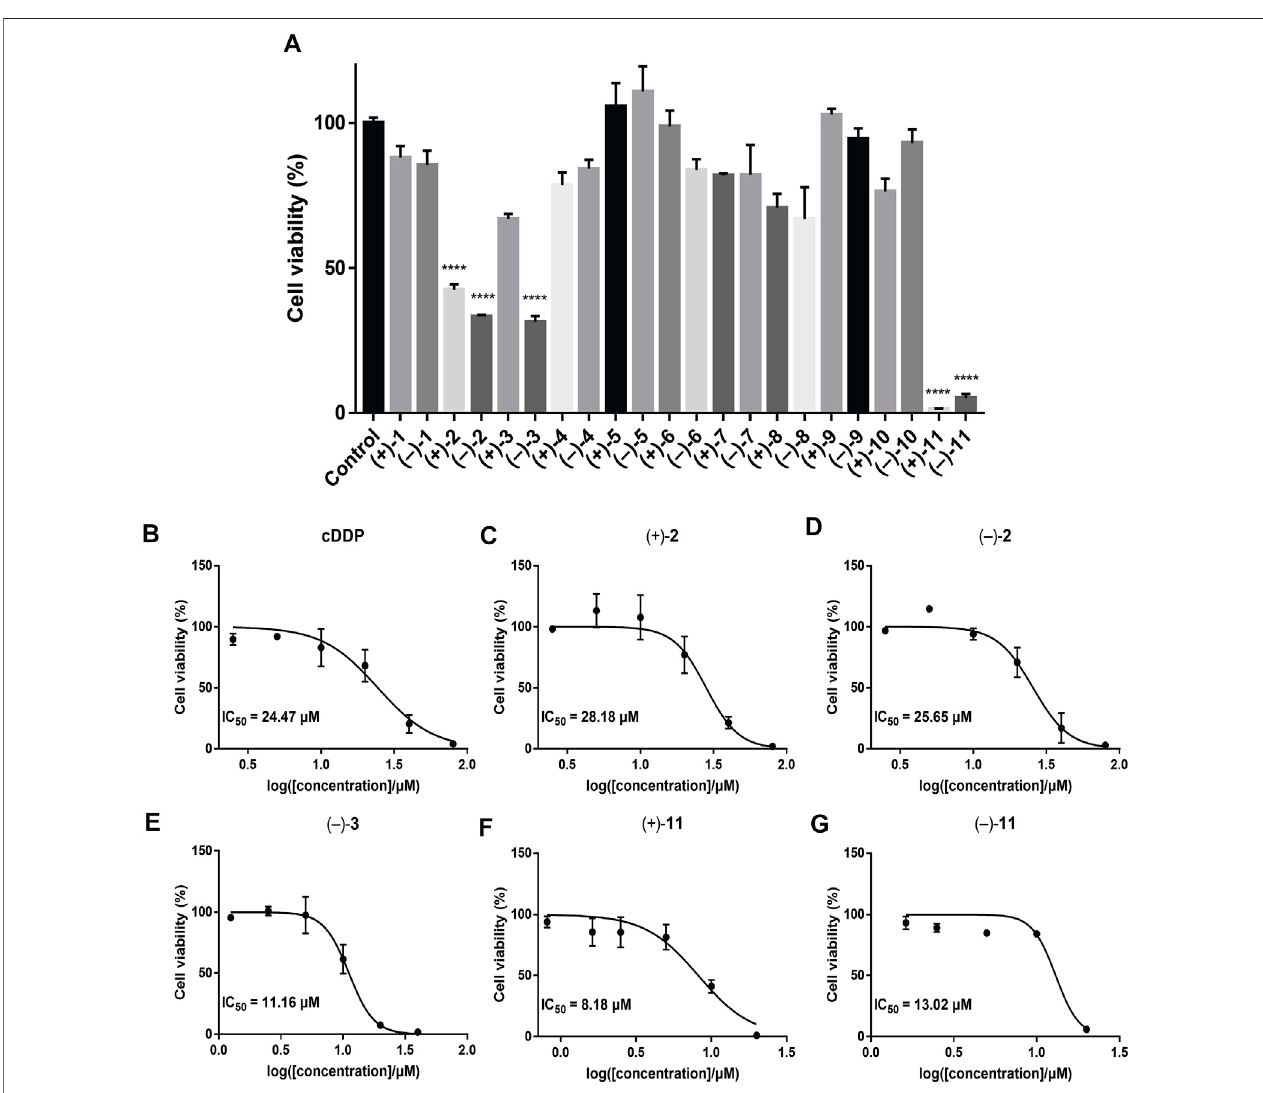
FIGURE 6 | Cell viability of the compounds in MDA-MB-231 cells by CCK-8 assay. The results are represented as mean ± SD of triplicates. **** p < 0.0001 vs. control group. (A) Primary screening at 20 μ M. (B – G) Dose-response curves of cisplatin (positive control) and the tested compounds showing IC 50 values.